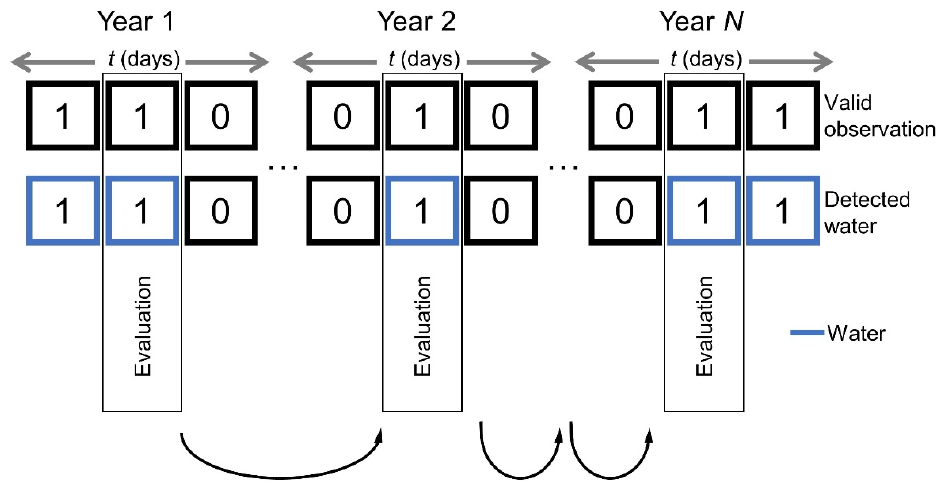
Figure 5. Seasonal probability on pixel-level by considering the water reoccurrence on a specific day of the year. Binary assessment: 1 ≙ true and 0 ≙ false.